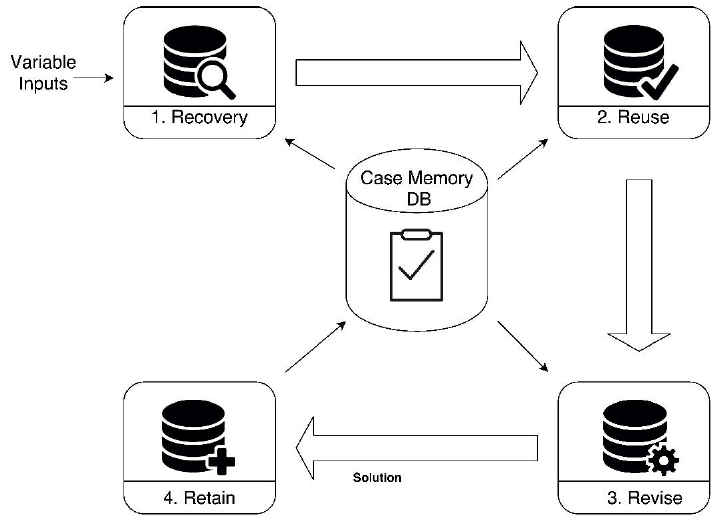
Figure 6. CBR agent for learning employee’s schedules.